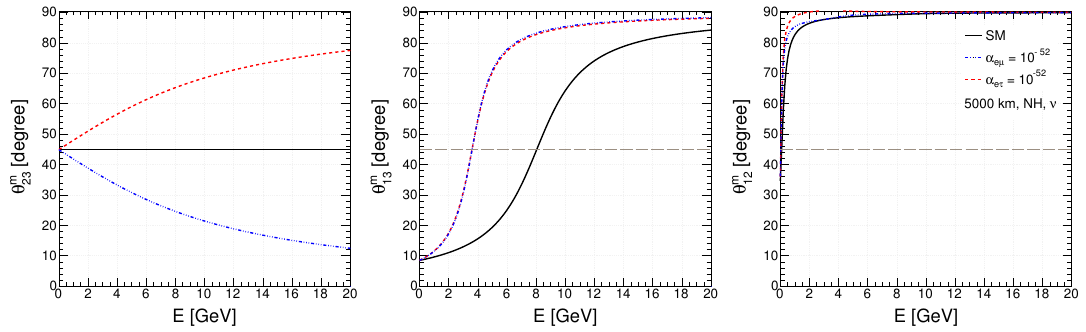
, (cid:18) m , and (cid:18) m 23 13 12